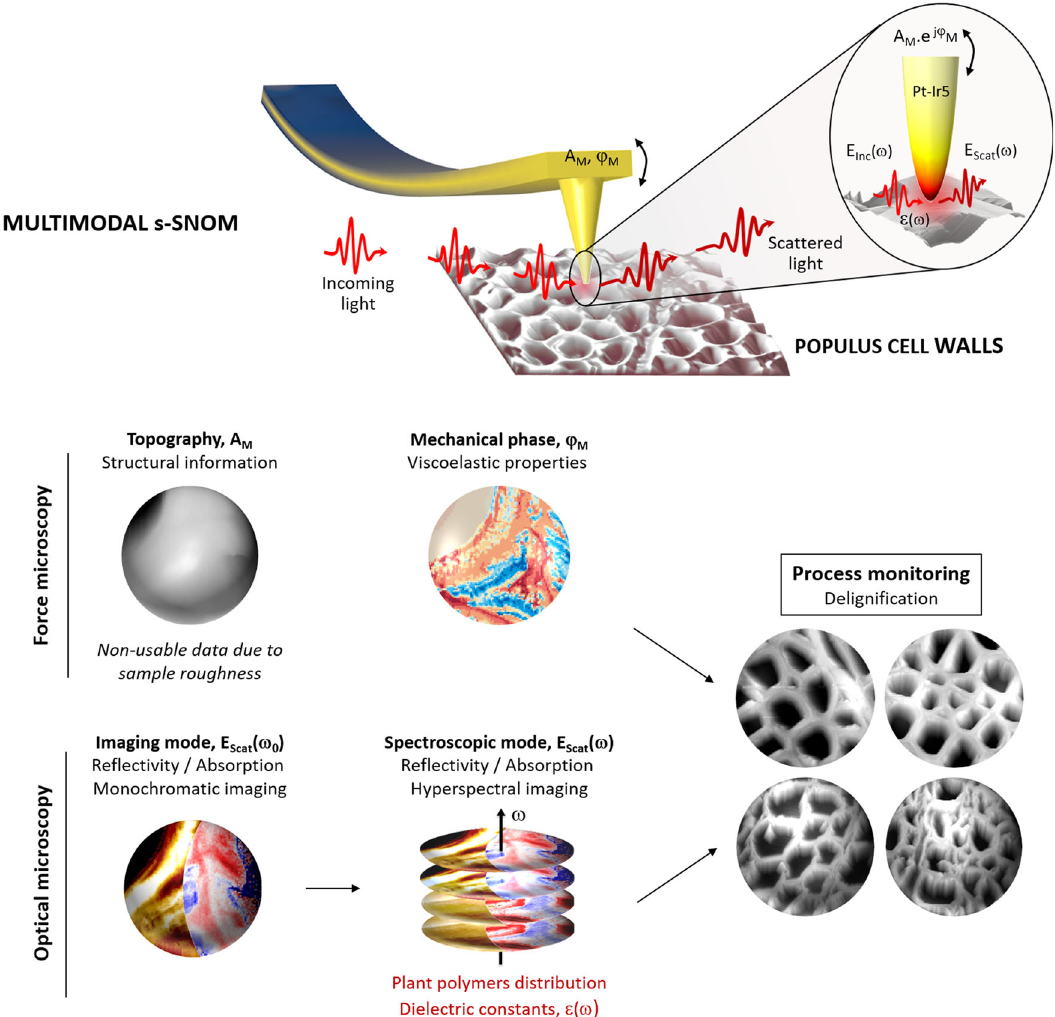
Fig. 1 The near- fi eld region of a tip-cell walls system carries information on the chemical and dielectric properties of the specimen. The s-SNOM signal is based on the analysis of the scattered radiation detected in the far- fi eld region. Shown is the microcantilever tip (oscillation amplitude A M and phase φ M ) engaging the PCW surface while interacting with incoming radiation pulses E Inc . The scattered fi eld E Scat is then detected and analyzed for its amplitude A φ Scat and phase Scat . These constants extracted from the tip-sample interaction are used in each mode to trace structural (topography, (mechanical phase, φ M ), and optical (re fl ectivity and absorption, A Scat , φ Scat ) information. The color contrast in the cantilever and the tip represents computed stress distribution and surface fi eld magnitude,